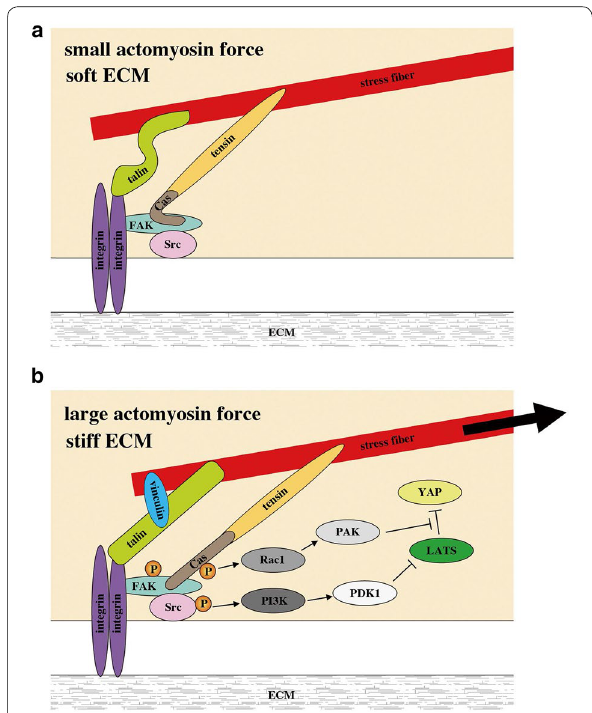
Fig. 3 A hypothetical model for YAP/TAZ regulation by tension at FAs. a Low tension FA with small actomyosin force and/or soft ECM. b High tension FA with large actomyosin force and stiff ECM. FA tension induces sequential phosphorylation (P) of FAK, Src and p130Cas (Cas). Phosphorylated Src activates the PI3K–PDK2 pathway, whilst the phosphorylated p130Cas activates the Rac1–PAK pathway. Activation of these pathways inhibits LATS-mediated phosphorylation of YAP, facilitating nuclear translocation of